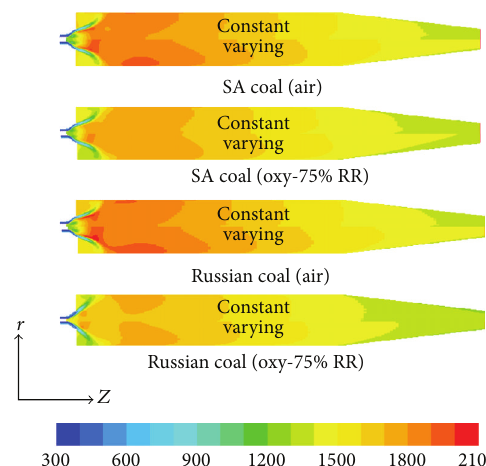
Figure 2: Temperature contours during the combustion of Russian and SA coal in air and in the oxy-75% RR scenario (on the top half of theaxisymmetricfurnacesarethepredictionsfromconstantparticle radiative properties; in bottom half are predictions from varying particle radiative